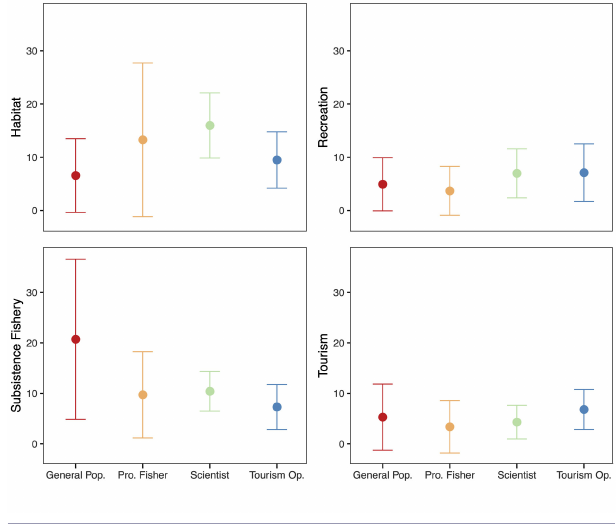
Fig. 4 . Average rankings with standard deviations of ecosystem services identified as having significant between-group differences by Kruskal-Wallis and post-hoc Dunn